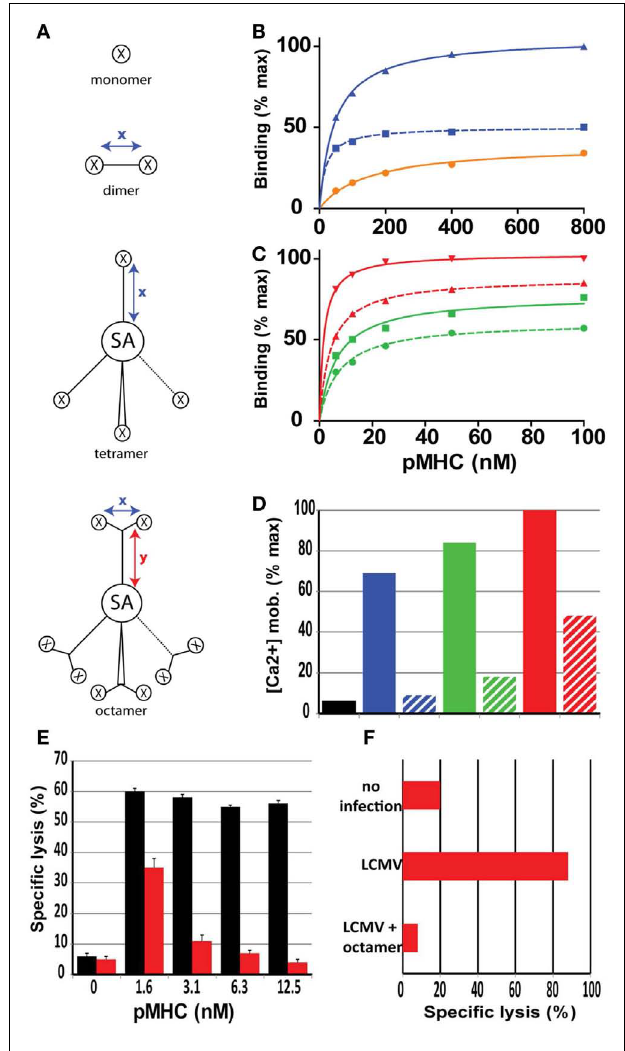
FIGURE 2 | Role of valence and spacer distances of soluble pMHC complexes on binding and activation of CD8 + T cells . (A) Cartoons of mono, di, tetra, and octamer pMHC complexes, in which x and y indicate maximal spacer distances in Å, X a pMHC monomer and SA streptavidin. The spacer distances for the pMHC dimers varies from 18 to 90Å. (B) Relative binding on CD8 + T cells of monomer (black), short dimer (blue), and long dimer (dotted blue). (C) Same as (B) with short tetramer (green), long tetramer (dotted green), short octamer (red), and long octamer (dotted red). Short distances are < 20Å and long distances are > 80Å. (D) Relative activation (Ca 2 + mobilization) of CD8 + T cells after binding of the represented pMHC complexes. (E) Specific lysis of target cells (GP33 peptide sensitized P815/Db cells) was assessed following incubation with LCMV d8 CD8 + CTL in the presence of Db/GP33 monomer (black bars) or Db/GP33 long octamer (red bars). (F) Specific lysis of GP33 peptide sensitized P815/Db cells was assessed in LCMV infected mice that were or were not (LCMV) injected previously with octamer. Presented data were derived from Ref.